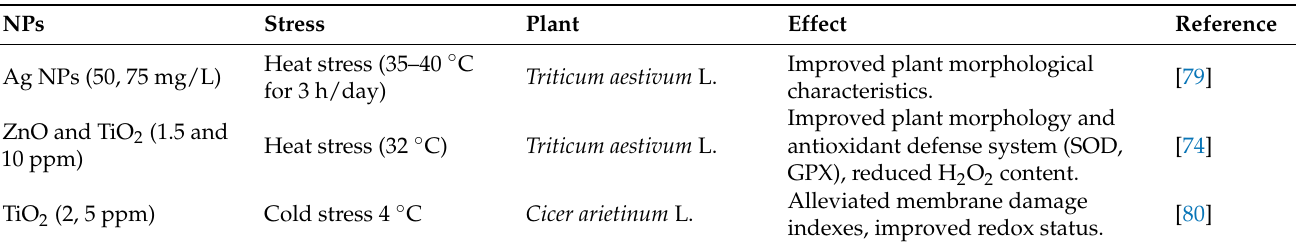
Table 2. Impact of NPs on plants under temperature